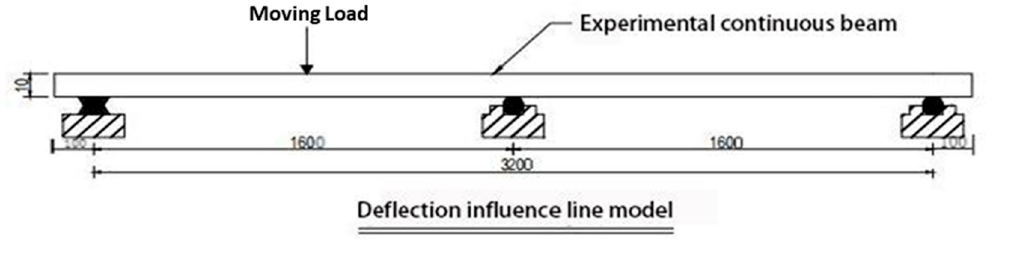
Figure 1. Experimental model.